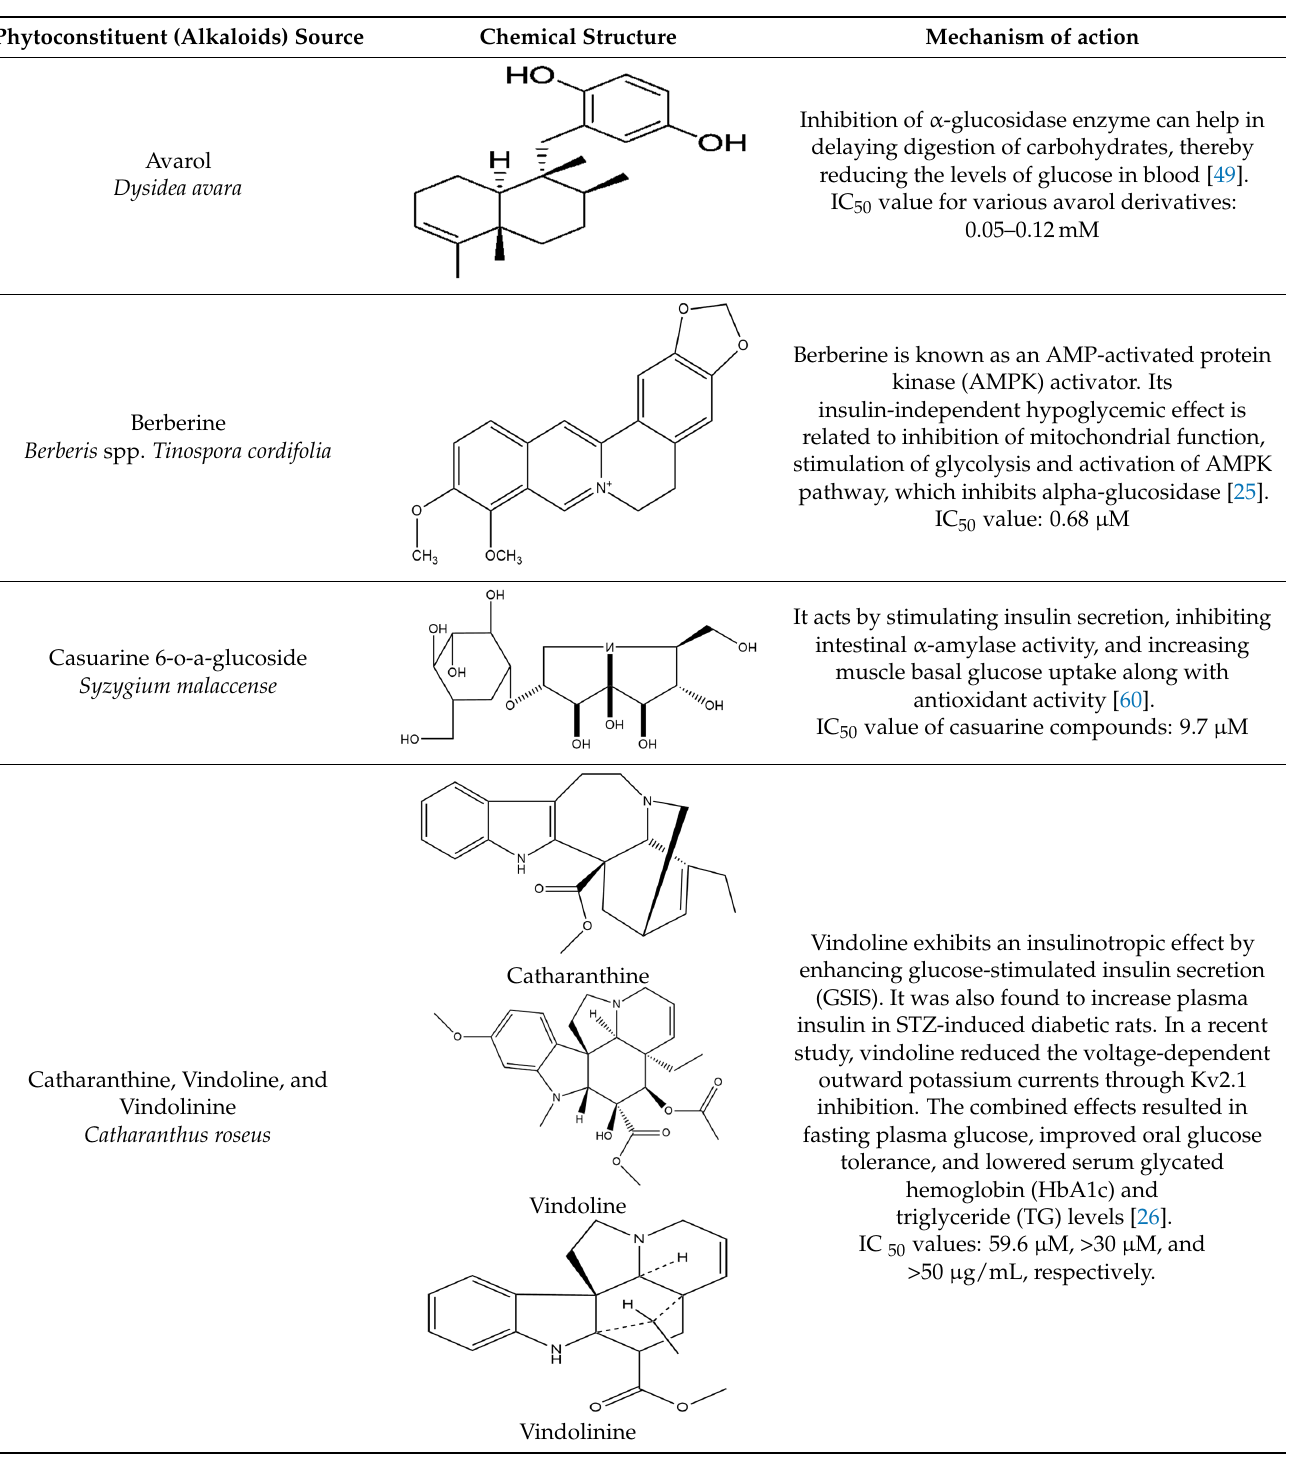
Table 1. Source and nature of alkaloidal phytoconstituents used for the management of diabetes mellitus [2].